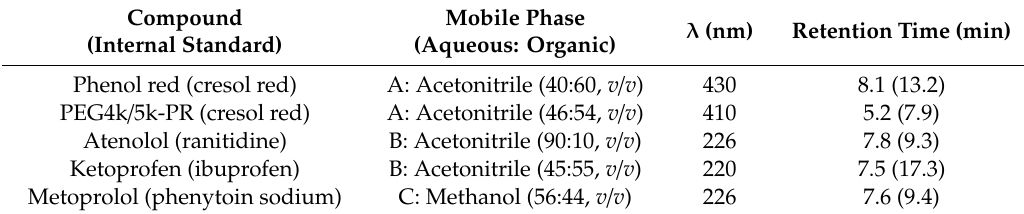
Table 1. HPLC conditions of the compounds (with isocratic